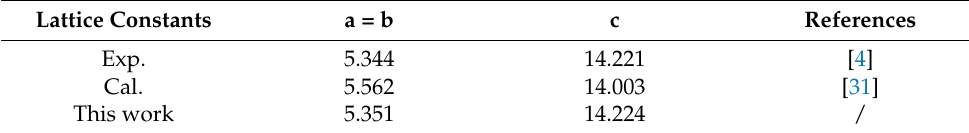
Table 1. Lattice constants of ZnSnO 3 (experimental, calculated, and this work, in Å). Lattice Constants a = b